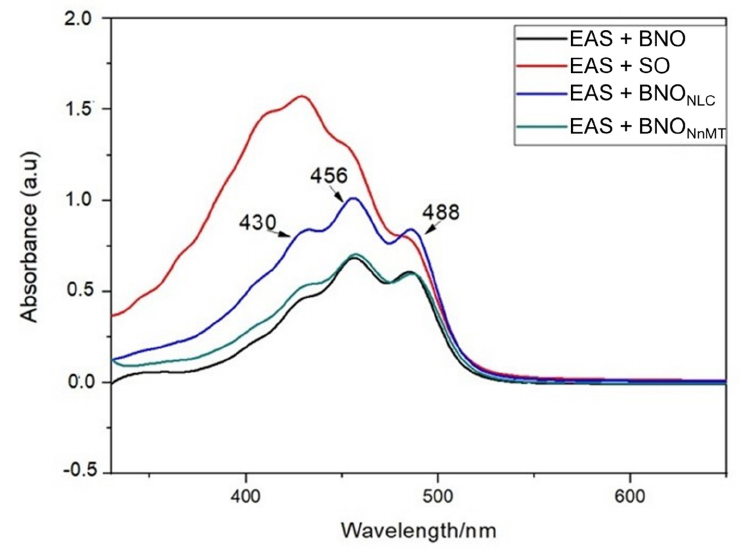
Figure 6. UV-VIS spectra of nanoemulsions formulations and NLCs containing annatto seed oily extract in chloroform at room temperature.